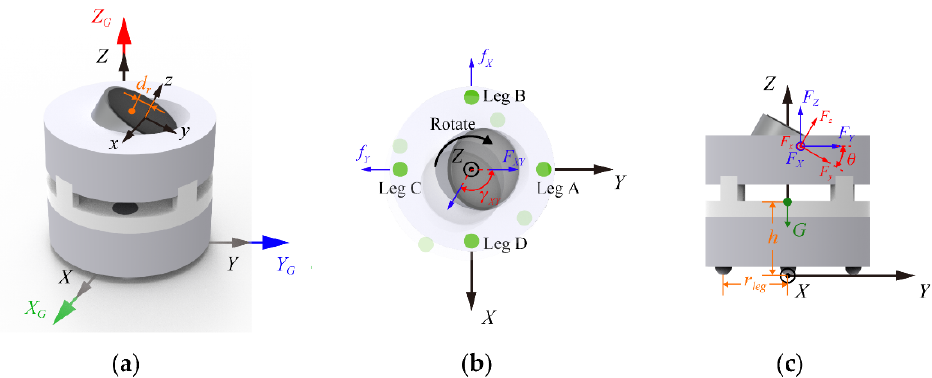
Figure 3. Definition of parameters and load distribution. In the coordinate system 𝑋𝑌𝑍 , the line from leg B to D is the 𝑋 axis, the center of the legs is the origin, and the 𝑋𝑌 plane is horizontal. ( a ) Cartesian coordinate systems in robot modeling. The forces on the robot resulting in rotating around the 𝑍 -axis in ( b ) and translation on the 𝑋𝑌 plane in ( c ).